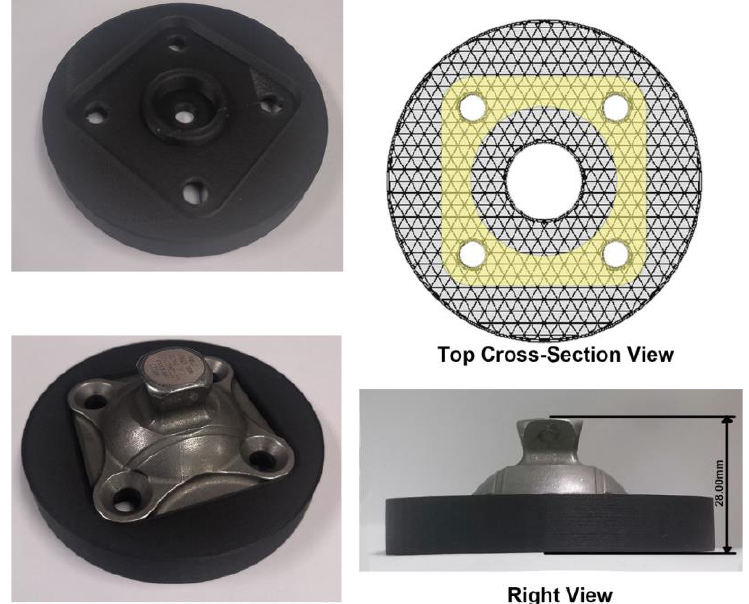
Figure 13. Details of the supporting part and the assembly with the adaptor.